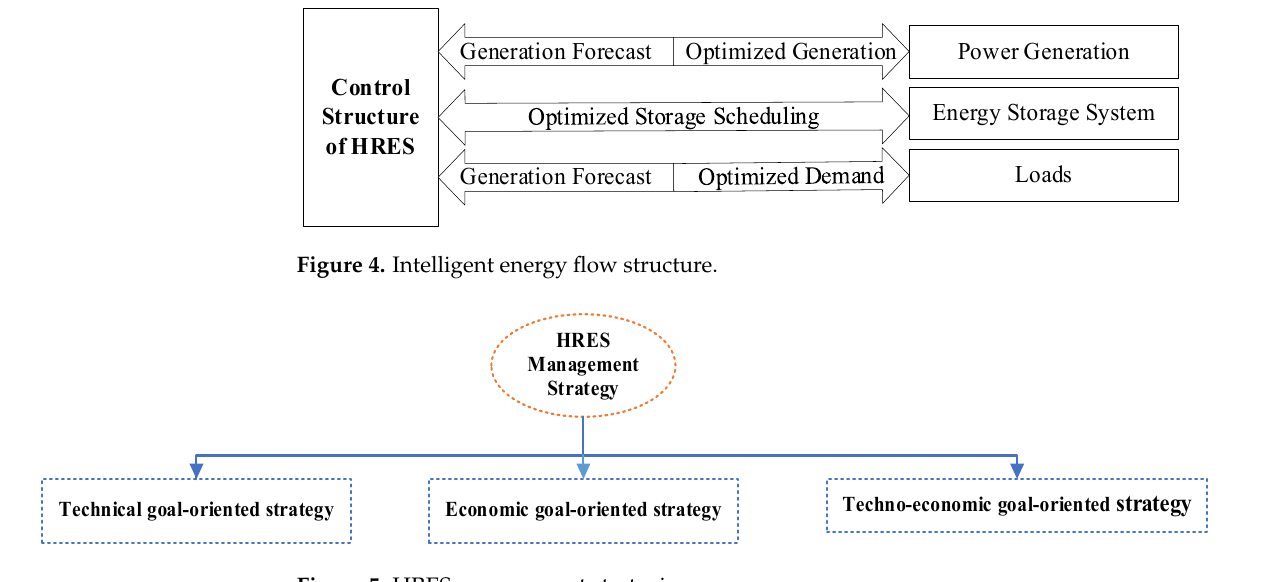
Figure 5. HRES management strategies.